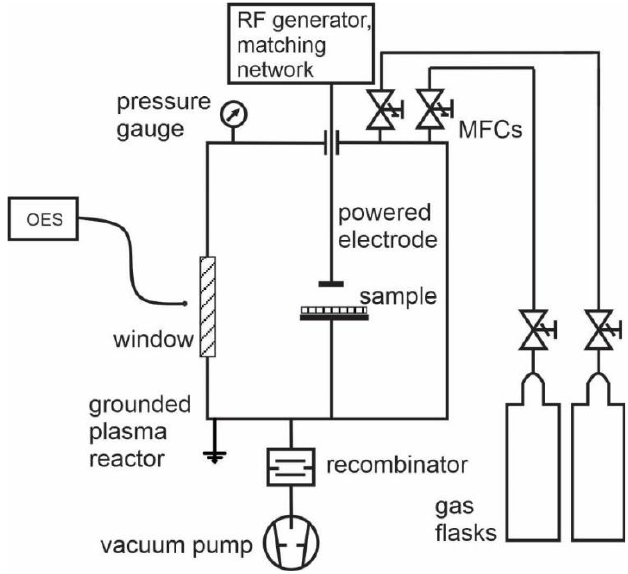
Figure 2. Schematic of the experimental system.